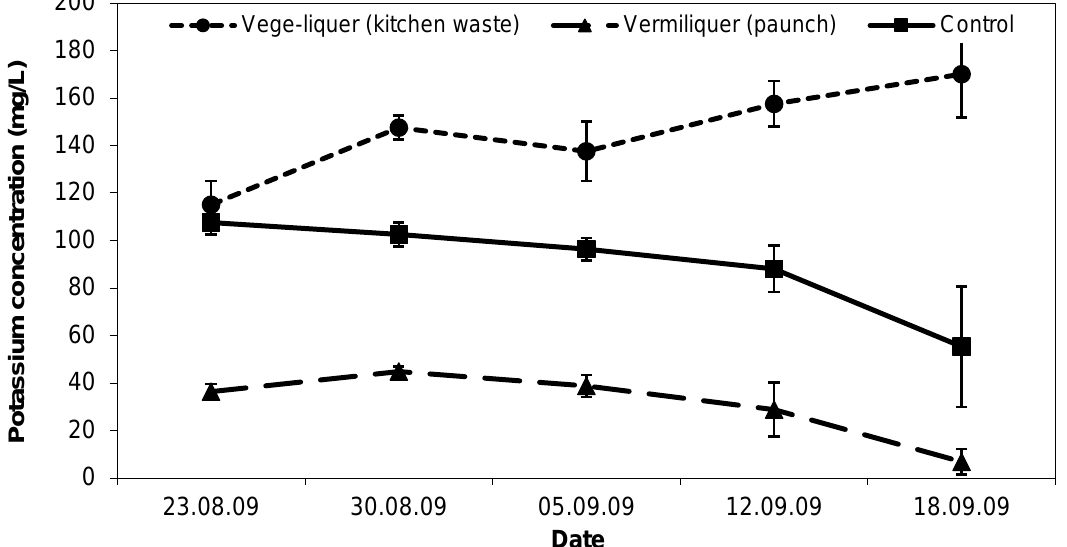
Figure 7. Trend in potassium concentration (mg/L) in the control, vermiliquer and vege-liquer solutions over time in Study VI, transplanted 22 August 2009. Vertical bars represent SD of the mean.